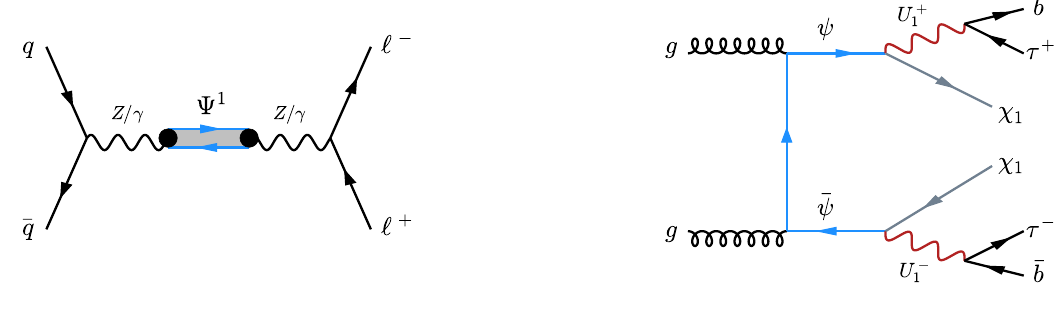
Figure 3 . (Left) Electroweak production of Ψ 1 and its subsequent decay into two leptons. (Right) A representative diagram for pair production of ψ , which both decay into bτχ